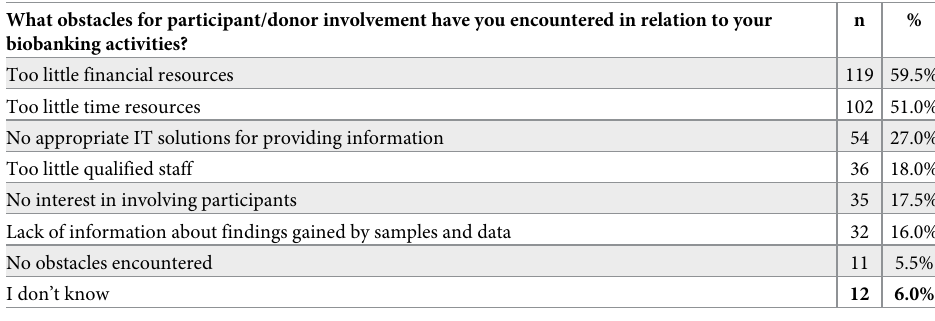
Table 9. Obstacles to participant